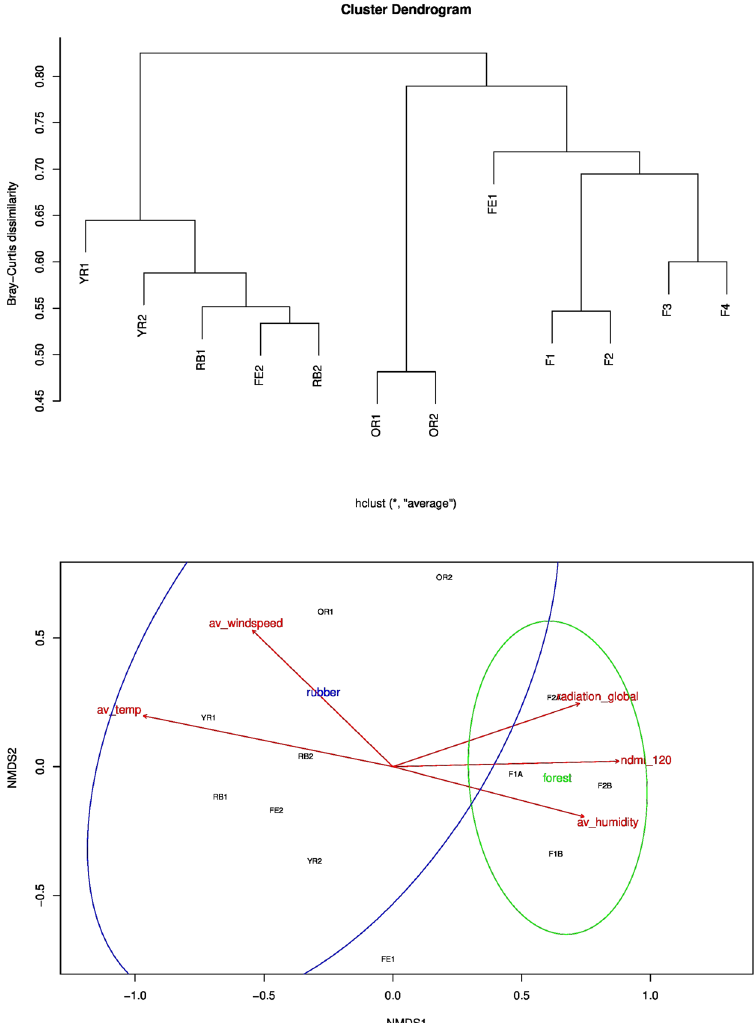
Figure 5. ( a ) Dendrogram depicting difference in bee community structure. YR = Young Rubber. OR = Old Rubber ( > 8 years). RB = Open River Rank. FE = Forest Edge. F = Forest. ( b ) Multivariate structure visualized with non-metric multidimensional scaling. Area within ellipse is 95% confidence interval for the 4 rubber and 4 forest sites. Also plotted are key environmental variables, particularly average temperature and NDMI (vegetation density